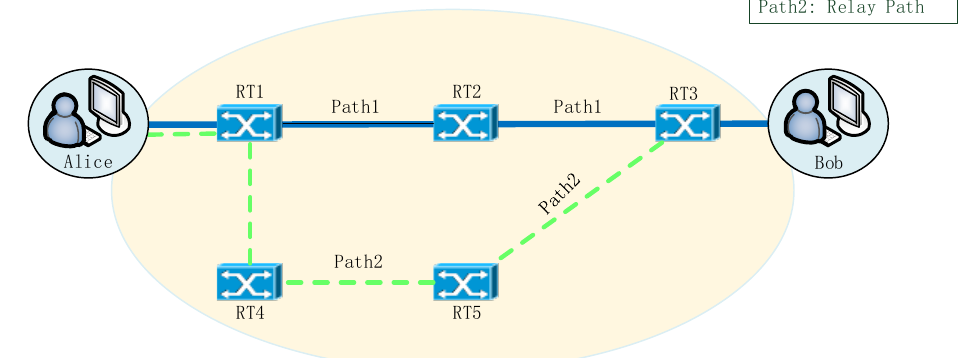
Figure 3. The topology of the application layer multipath relay service.